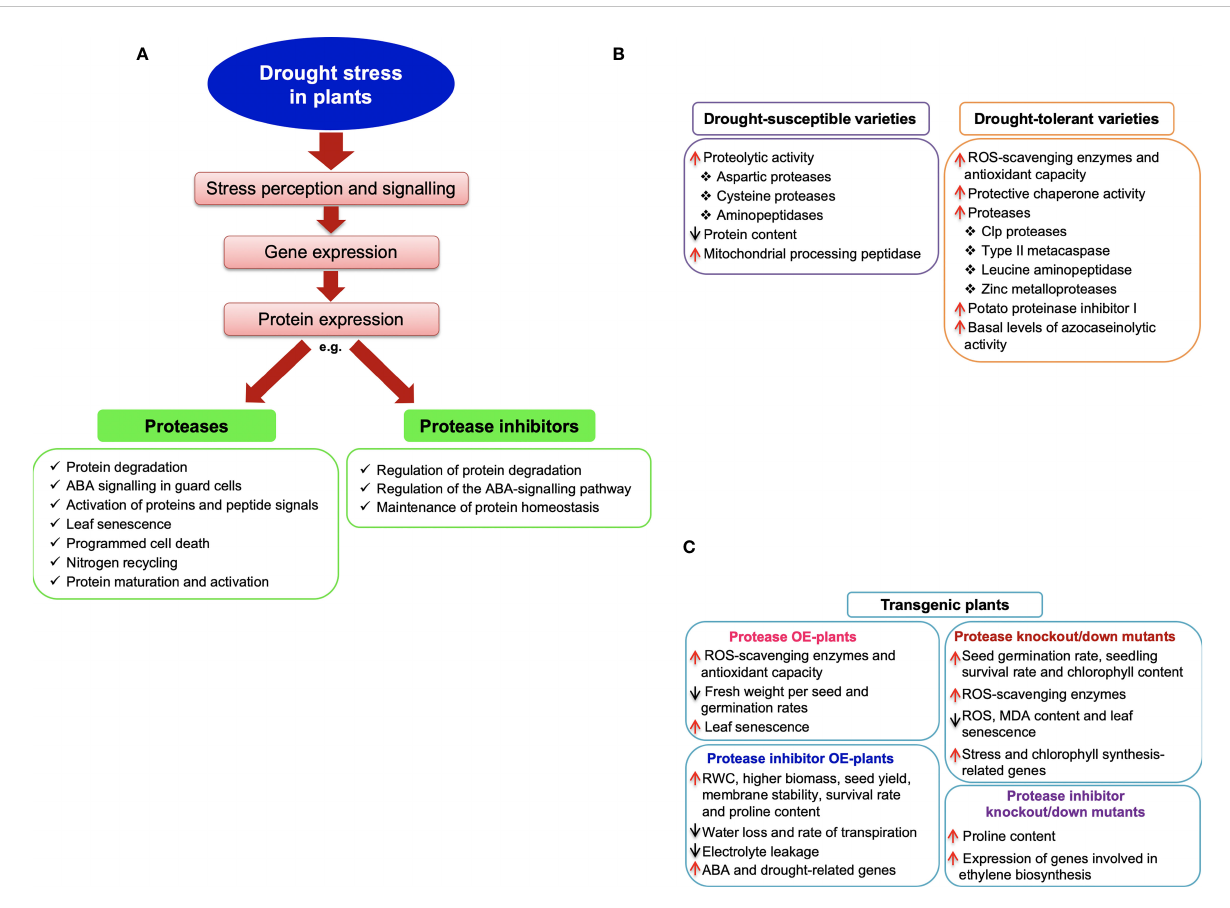
FIGURE 2 Regulation and functions of plant proteases and protease inhibitors extrapolated from various drought-stress studies. (A) A simpli fi ed schematic diagram showing that drought stress signalling in plants results in changes in gene and protein expression patterns such as those of proteases and protease inhibitors. (B) Differential regulation of plant proteases and protease inhibitors in drought-susceptible and tolerant plant varieties under drought stress. (C) Physiological effects of transgenic overexpression and repression of proteases and protease inhibitors in plants under drought stress. Red arrows indicate up-regulation or increase, while black arrows indicate down-regulation or decrease. ABA, abscisic acid; Clp, caseinolytic protease; MDA, malondialdehyde; ROS, reactive oxygen species; RWC, relative water content; OE-plants, overexpression-plants. (Cruz de Carvalho et al., 2001; Hieng et al., 2004; Huang et al., 2007; Chen et al., 2010; Simova-Stoilova et al., 2010; Ford et al., 2011; Yao et al., 2012; Ashoub et al., 2013; Jedmowski et al., 2014; Faghani et al., 2015; Tiwari et al., 2015; Wang et al., 2015; Cheng et al., 2016; Chmielewska et al., 2016; Wu et al., 2016; Islam et al., 2017; Tan et al., 2017; Gomez-sanchez et al., 2019; Goche et al., 2020; Malefo et al., 2020; Sebastia ́ n et al., 2020; Mishra et al., 2021; Wang et al.,